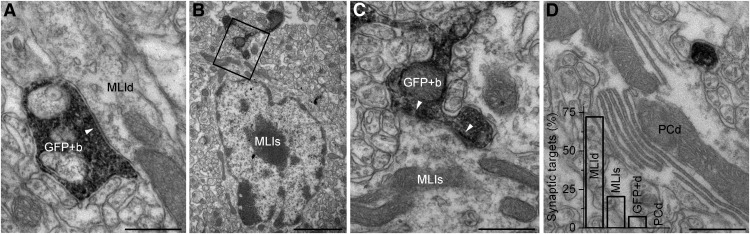
GlyT2-GFP-expressing axons target MLIs. A, Electron micrograph showing a GlyT2-GFP-DAB-positive axon varicosity (GFP+b) making a symmetrical synapse (arrowhead) with a smooth, thin, nonspiny MLI dendrite (MLId). Scale bar, 500 nm. B, Electron micrograph showing a GFP+b establishing a symmetrical synapse with a MLI soma (MLIs). Scale bar, 2 μm. C, Electron micrograph of the boxed region in B showing the synaptic junctions (arrowheads) at a higher magnification. Scale bar, 500 nm. D, Electron micrograph showing a thin GlyT2-GFP-DAB-immunoreactive interbouton axon segment (black precipitate) adjacent to, but lacking a synapse with, a PC dendrite (PCd). Scale bar, 500 nm. Bar graph shows the percentage of synapses formed by GlyT2-GFP-DAB-immunoreactive axons in MLId, MLIs, GlyT2-GFP-DAB-immunoreactive dendrites (GFP+d), and PCd.